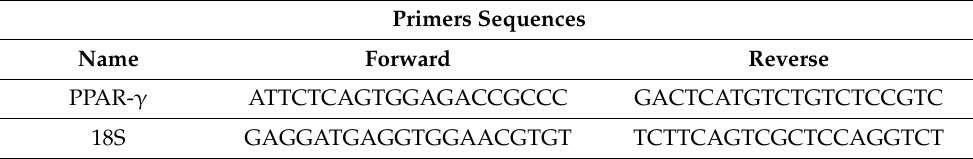
Table 2. Primers sequences.